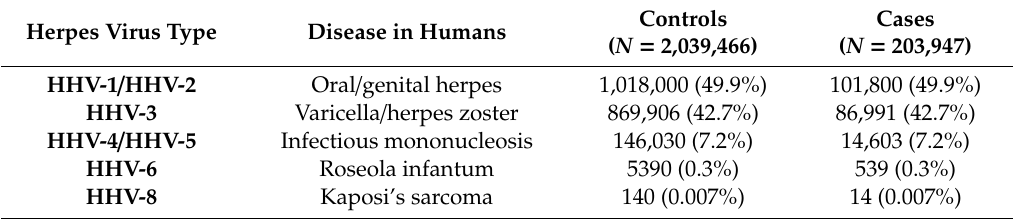
HHV: Herpesviruses. HHV: